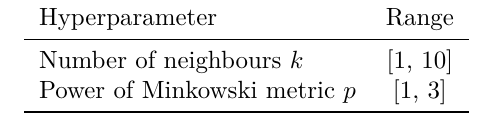
Table 2. Hyperparameters for training settings to- gether with ranges as used for Bayesian Optimisation of kNN